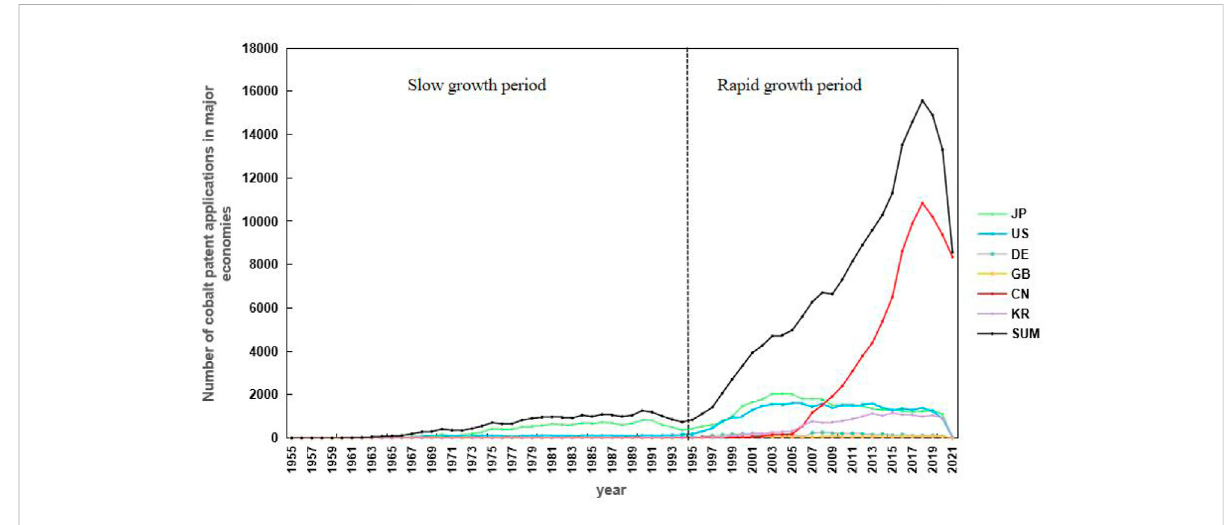
FIGURE 2 Global trends in cobalt technology patent applications by major